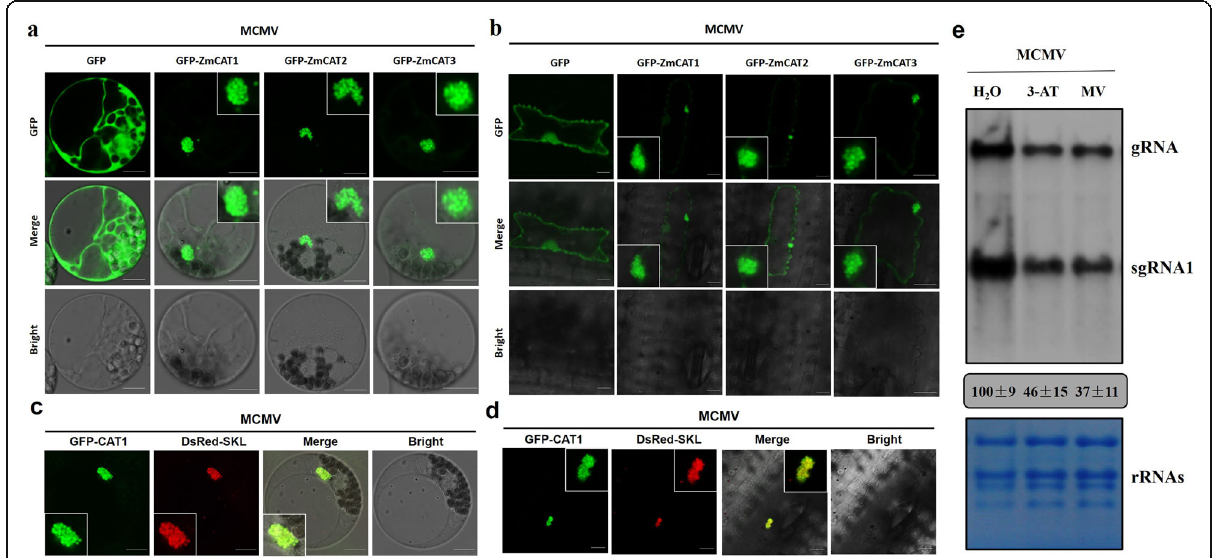
Fig. 5 The peroxisome localization of ZmCATs is required for viral replication of maize chlorotic mottle virus (MCMV). a , b Subcellular localization of ZmCATs in maize protoplasts in the presence of MCMV in vitro transcripts ( a ) and in MCMV-infected leaves ( b ). The green/red fluorescence was observed at 24 hpt ( a ) and 36 hpb ( b ), respectively. Bars, 10 μ m. c , d GFP-ZmCAT1 co-expressed with DsRed-tagged peroxisome marker SKL in MCMV-infected maize protoplasts ( c ) and MCMV-inoculated maize leaves ( d ). The green/red fluorescence was observed at 24 hpt ( c ) and 36 hpb ( d ), respectively. Bars, 10 μ m. e Protoplasts were inoculated with MCMV in vitro transcripts and incubated at 25 °C for 18 h in the presence of 20 mM 3-AT (3-amino-1, 2, 4-triazole) or 10 μ M MV (methyl viologen). The accumulation levels of MCMV genomic RNA were determined by Northern blot and visualized with the IMAGE J software. The numbers shown below the gel indicate the ratio of MCMV genomic RNA (top band) accumulation level in 3-AT/MV-treated maize protoplasts to that in the H 2 O-treated control maize protoplasts (presented as 100). Relative genomic RNA accumulation was calculated from maize protoplast Northern blot data for three separate inoculation experiments and represents mean ± standard